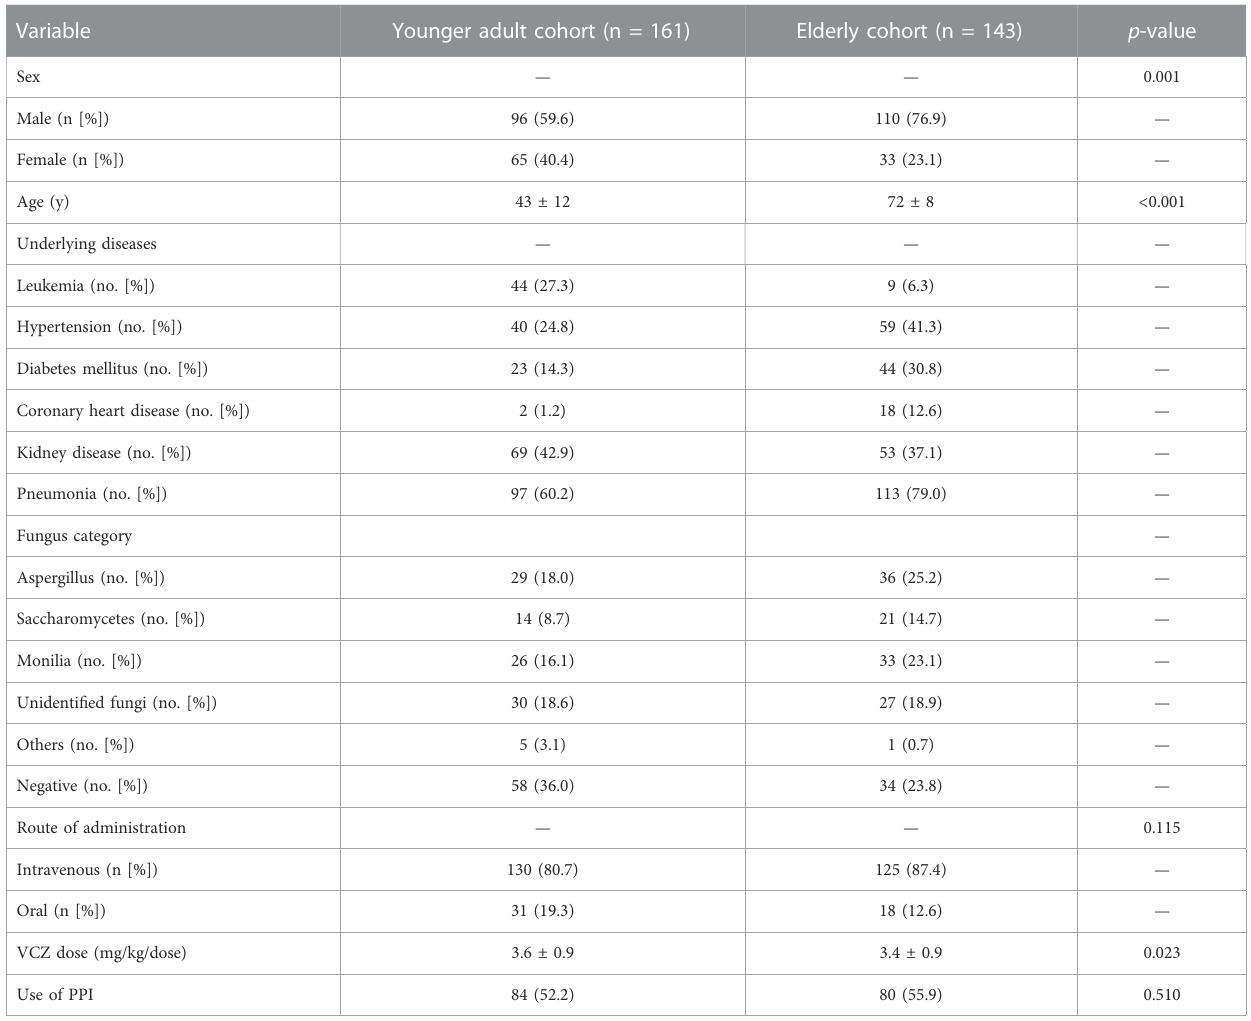
TABLE 1 Demographic and clinical chacteristics of patients in the two cohorts.